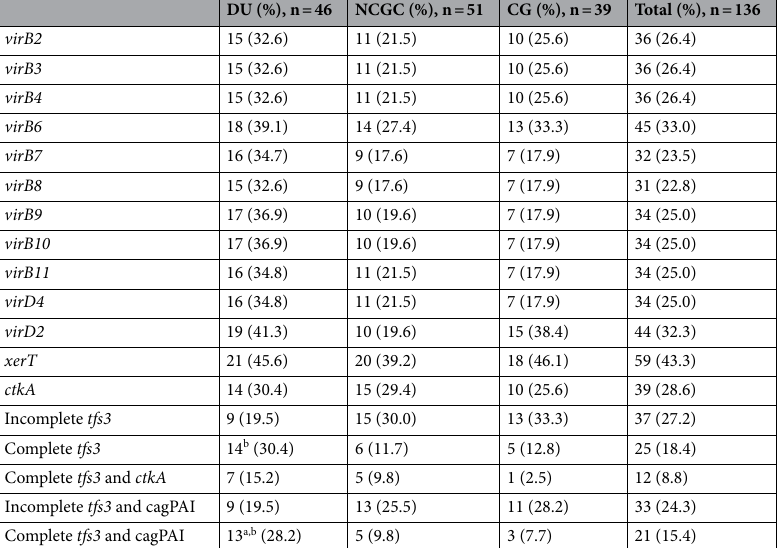
Table 2. Prevalence of tfs3 ICE T4SS genes in DU, NCGC, and CG. a Indicated significant difference in prevalence between DU and CG at P < 0.05. b Indicated significant difference in prevalence between DU and NCGC at P <